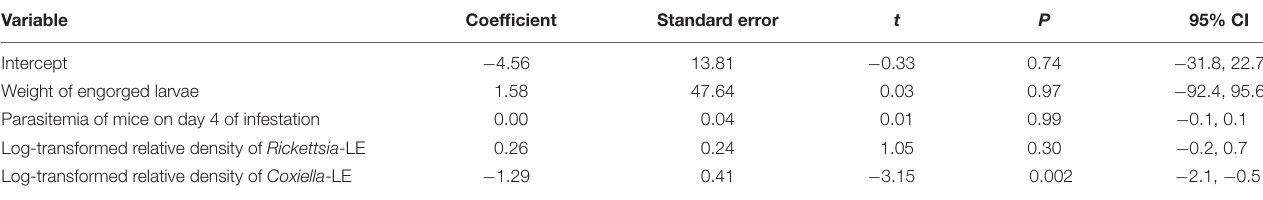
TABLE 6 | Potential factors associated with infection of R. haemaphysaloides nymphs as revealed by a two-level logistic regression model.